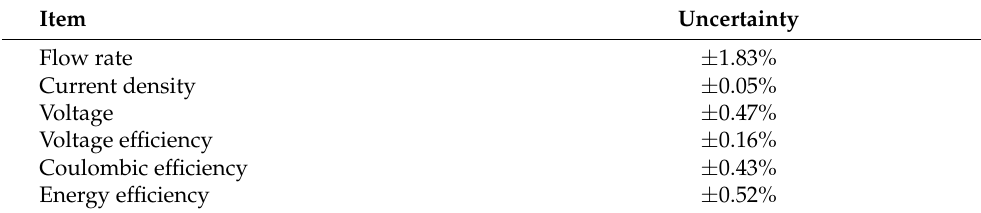
Table 3. Uncertainty of measurement.